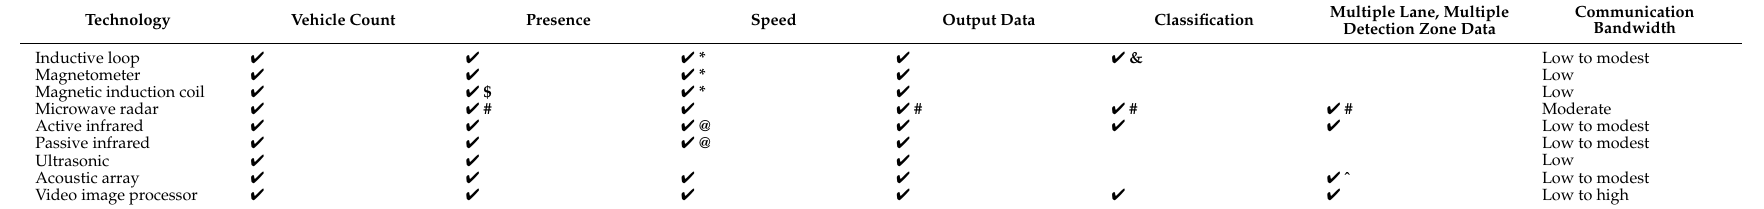
Table 2. Traffic output data and communications bandwidth of commercially available sensors